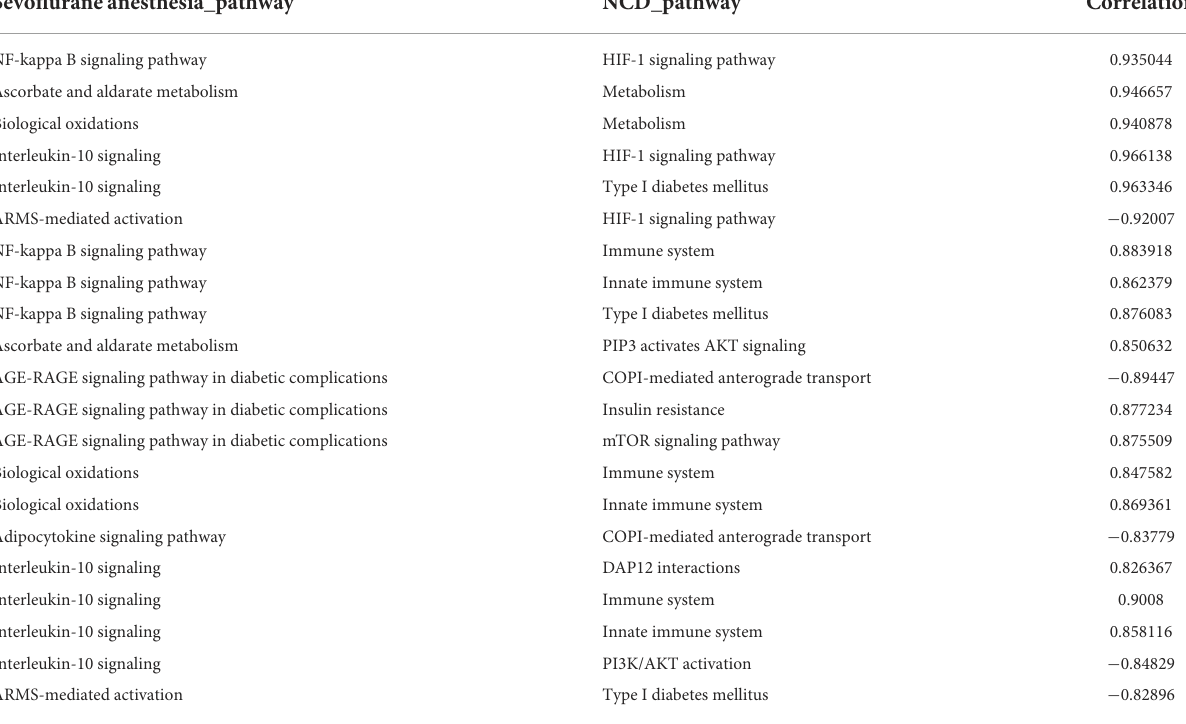
TABLE 4 Correlation of 7 Sevoflurane anesthesia DE-pathways and 11 NCD hub hub pathways. Sevoflurane